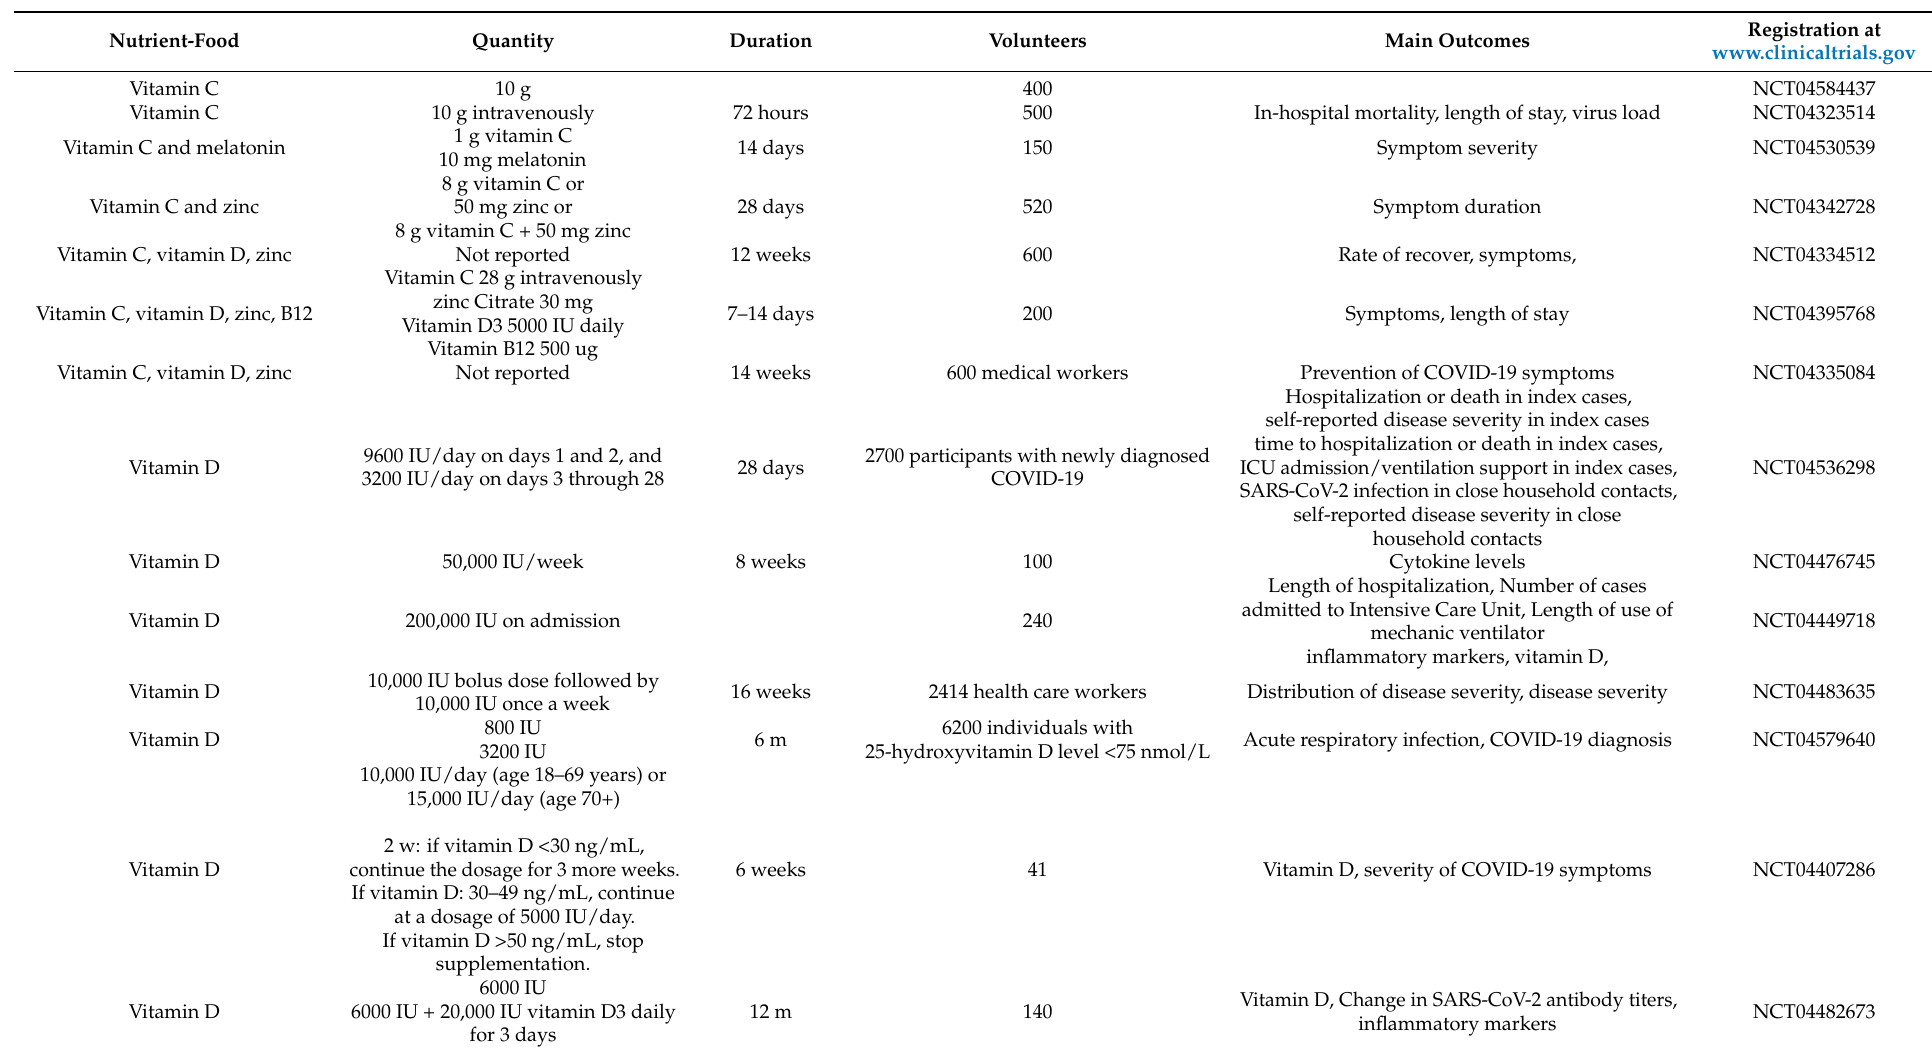
Table 2. Clinical trials regarding COVID-19 and foods or nutrients with anti-PAF